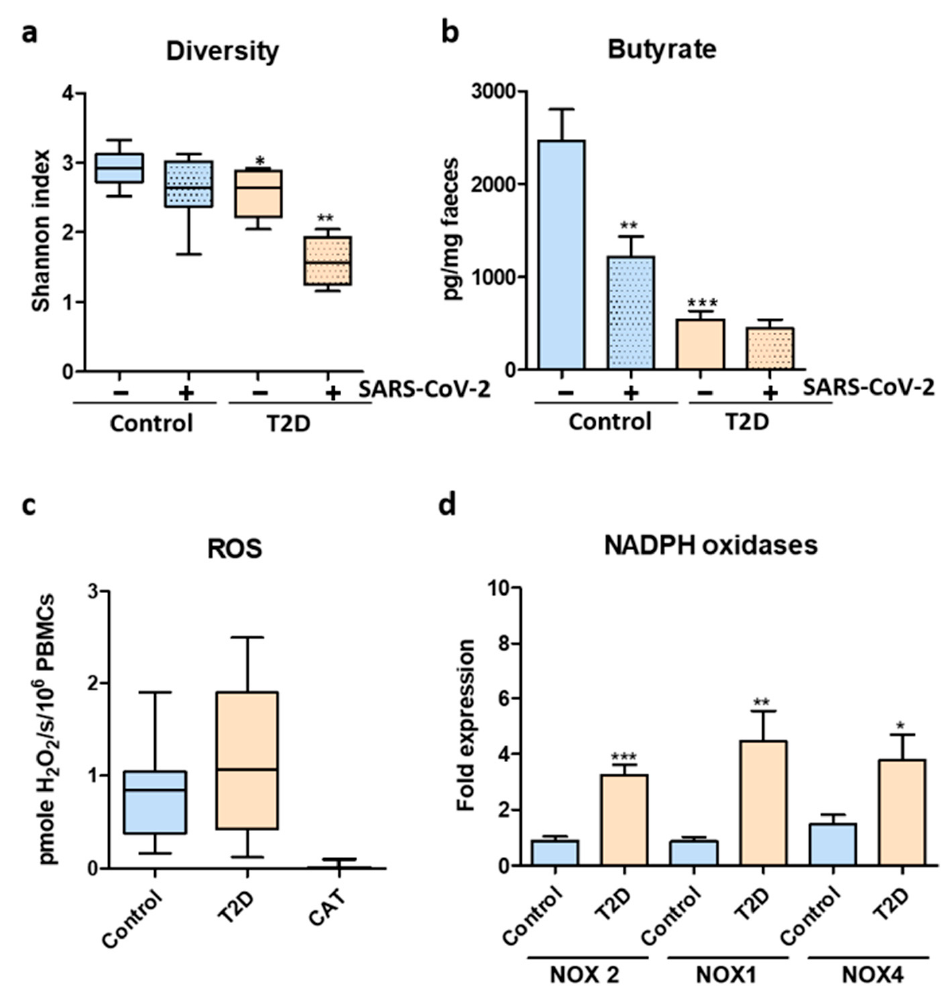
Figure 2. Microbiome dysbiosis and oxidative stress in T2D patients after SARS-CoV-2 infection. ( a ) Microbiome alpha diversity measured by Shannon index. ( b ) Fecal butyrate levels before and after SARS-CoV-2 infection. ( c ) ROS quantification in PBMCs harvested from SARS-CoV-2-infected healthy controls and T2D patients. ( d ) NOX1, NOX2 and NOX4 expression in PBMCs from SARS- CoV-2-infected healthy controls and T2D patient; CT-catalase control. For ( a , b )—statistical analysis was performed by 1-way ANOVA post hoc Bonferroni test and for ( c , d )—statistical analysis was performed using Unpaired t -test with Welch’s correction. The statistical significance levels: *, p < 0.05; **, p < 0.01; ***, p < 0.001. Conversely, levels of the beneficial microbe Faecalibacterium prausnitzii was depleted after SARS-CoV-2 infection, both in healthy controls and in T2D patients (Figure 3c). In case of Bacteroides spp., an important and predominant member of the human microbi- ome, no significant alterations were identified after SARS-CoV-2 infection (Figure 3d).